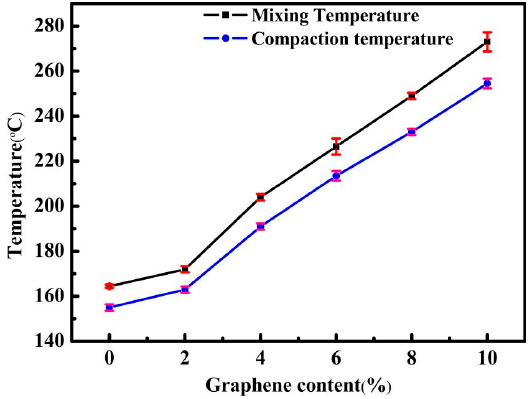
Figure 12. Mixing temperature and compaction temperature of control asphalt and GMAs.